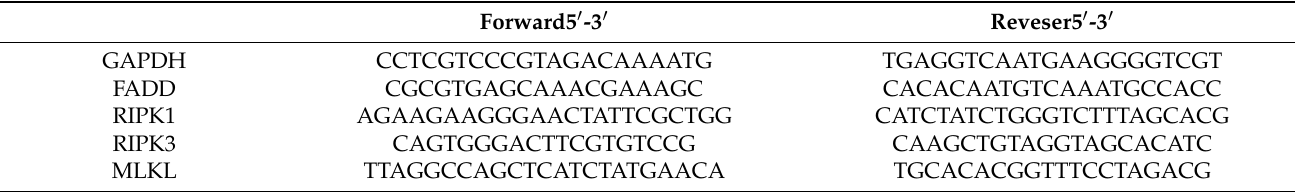
Table 2. Primer sequences for real-time quantitative